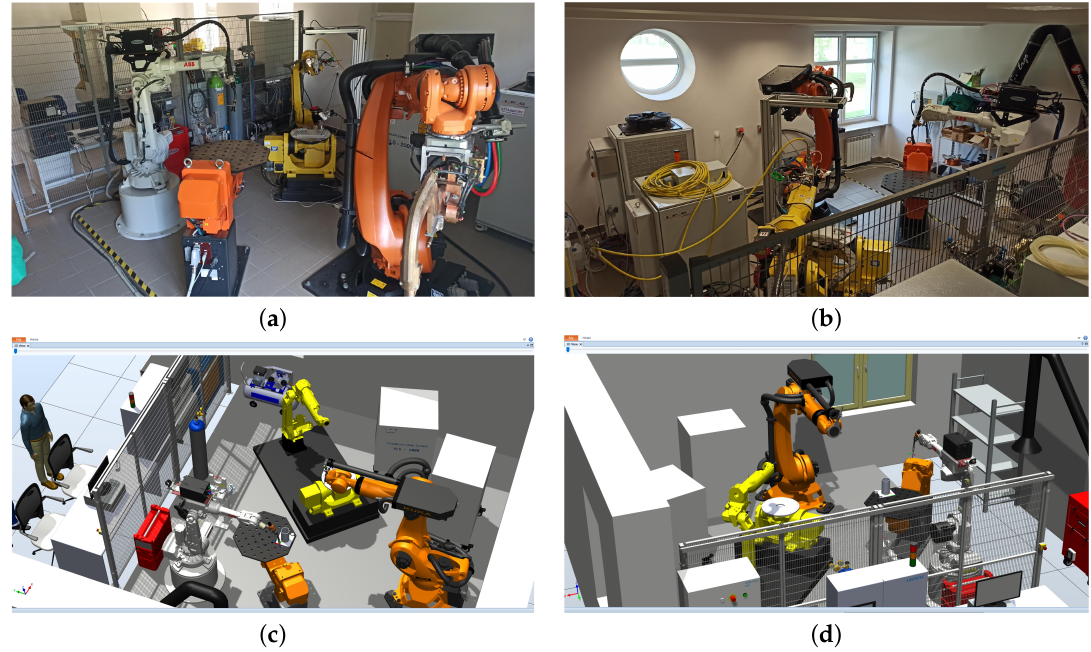
Figure 2. Test stand: ( a , b ) real station; ( c , d ) simulation.